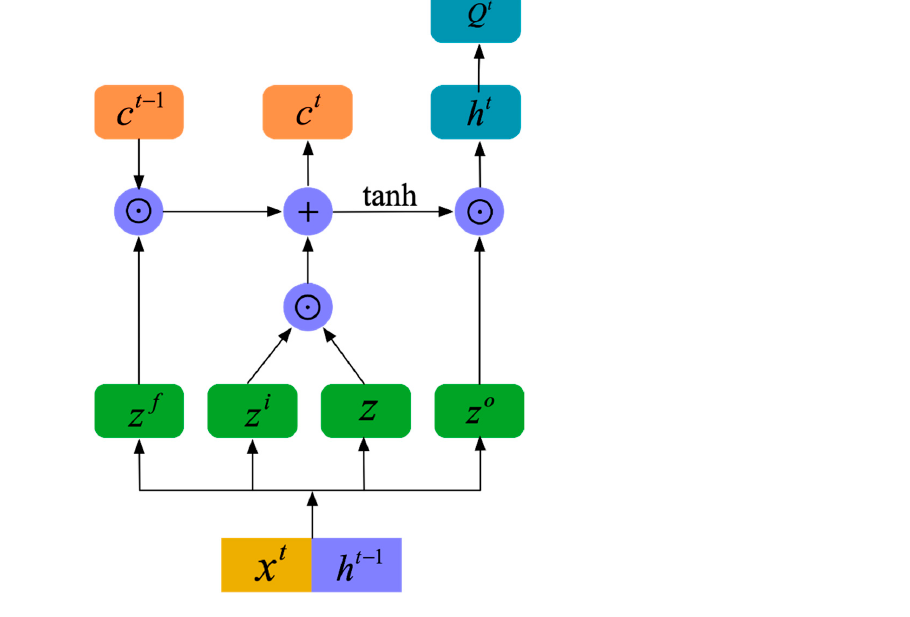
Figure 5. The internal structure of the long- and short-term memory neural network (LSTM) unit. Salimans et al. [34] introduced a feature loss item and compares the features extracted from the real and fake images in the middle layer of the discriminator. This idea was